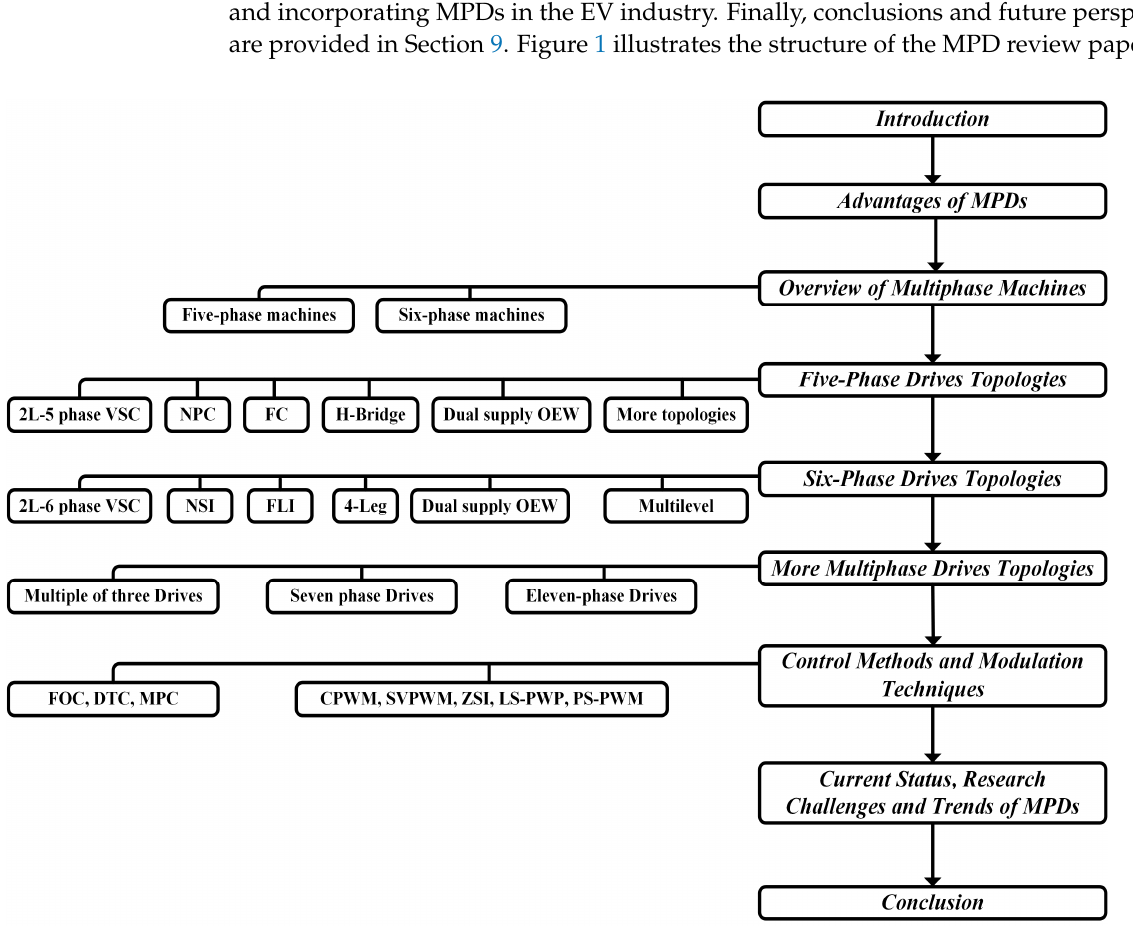
Figure 1. Schematic diagram illustrating different sections of the review paper on MPDs.